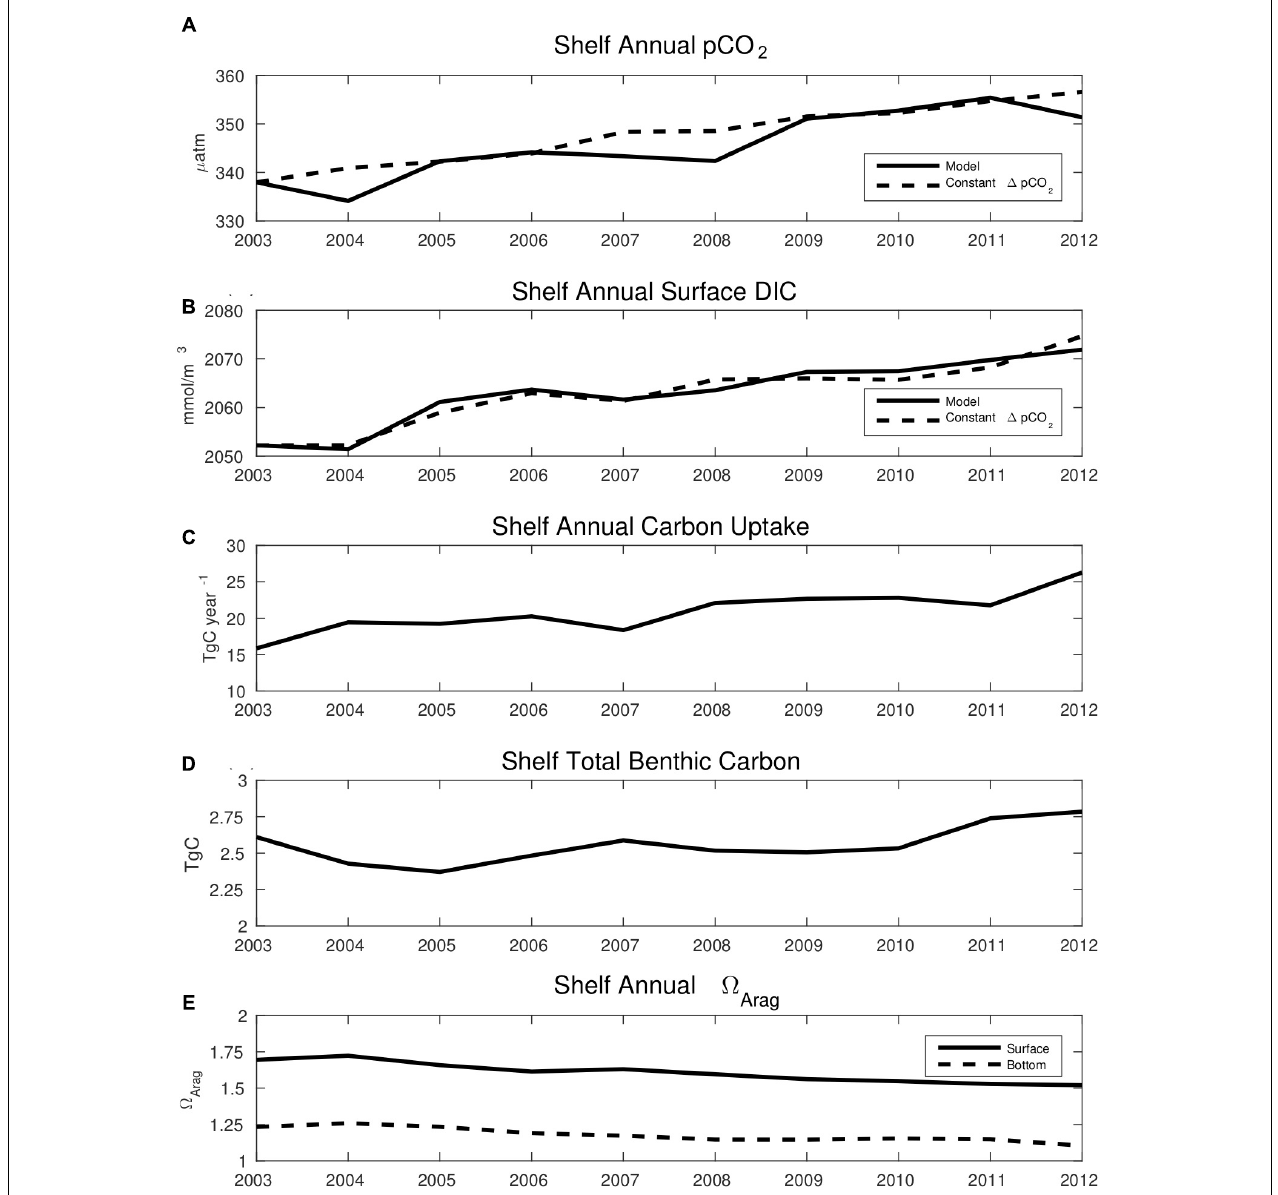
FIGURE 12 | Time series plots of annual average model (A) surface ocean p CO 2 and (B) surface DIC. The dashed line in (A) represents the expected increase in surface ocean p CO 2 based on the model air-sea p CO 2 disequilibrium in 2003, combined with the yearly increase in atmospheric CO 2 . The dashed line in (B) represents the excepted increase in surface ocean DIC, calculated from the expected surface p CO 2 values shown in the dashed line of (A) , and the model values of total alkalinity, salinity, and temperature. (C) Total ocean carbon uptake and (D) total benthic carbon over the entire Bering Sea shelf. (E) Annual average values of surface (cid:127) Arag (solid line) and bottom water (cid:127) Arag (dashed